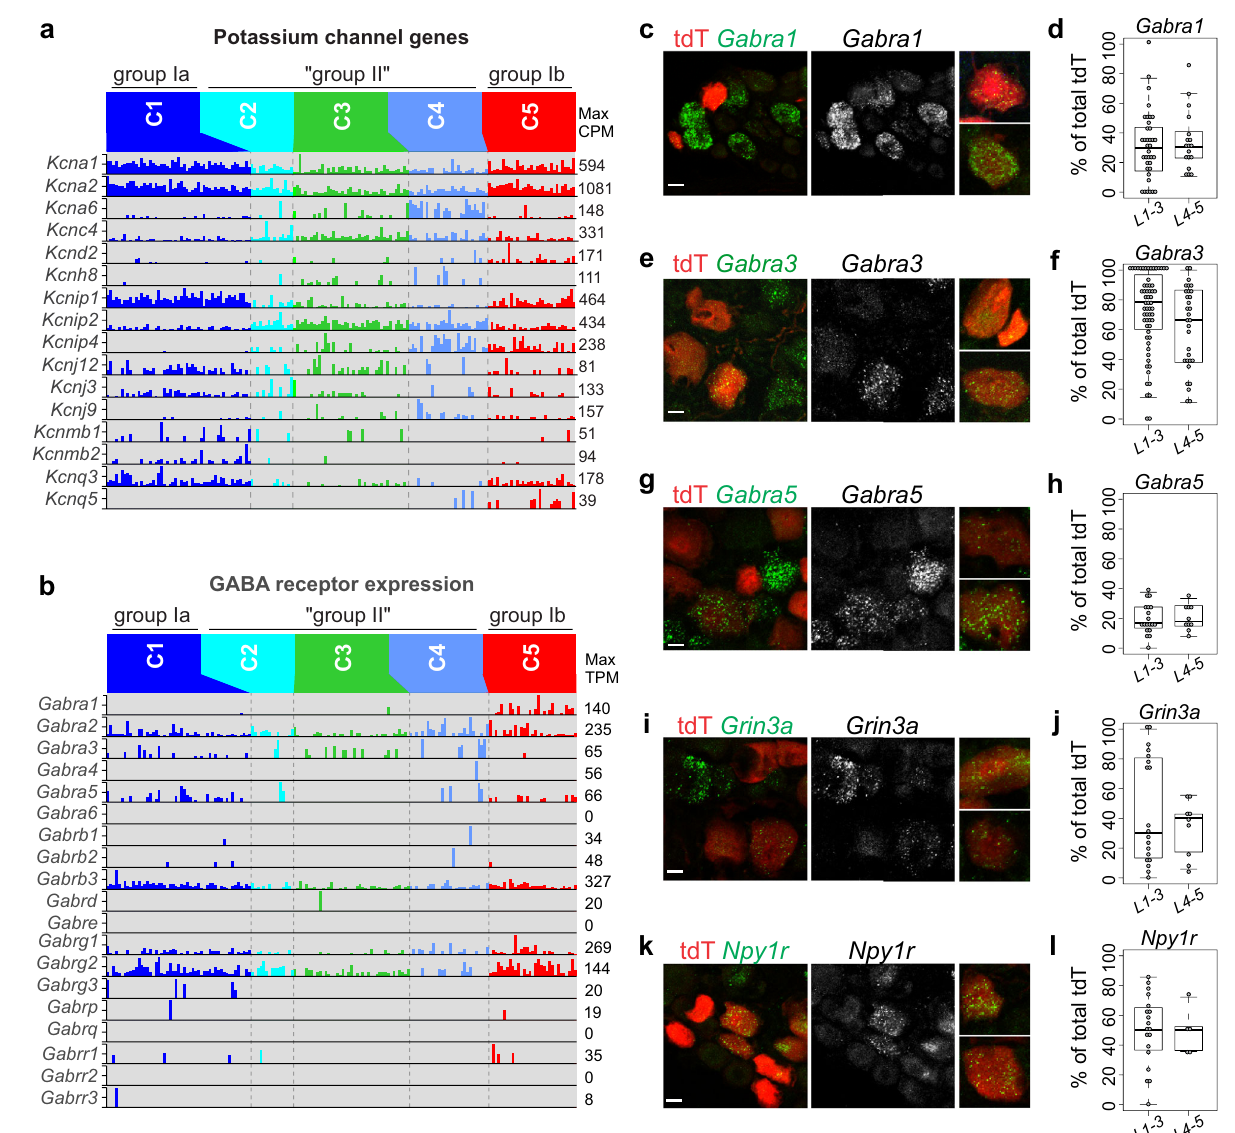
Fig. 5 Circuit features of MS and GTO afferent sensory subtypes. Bar graphs showing expression (in CPM) of annotated K v channel and auxiliary subunit genes ( a ), and GABA A receptor subunits ( b ) across the fi ve putative cell types identi fi ed from the clustering of single-cell RNAseq data. c – h Distribution patterns of the GABA A receptor units Gabra1 ( c ), Gabra3 ( e ), and Gabra5 ( g ) in tdT + neurons in adult ( ≥ p56) PVRx3:tdT mice. Images of individual neurons represent examples of observed Gabra + tdT + neurons other than those observed in the main image. Percentage of Gabra1 + tdT + ( d ), Gabra3 + tdT + ( f ), and Gabra5 + tdT + ( h ) (of all tdT + neurons) in p56 mice, at rostral (L1-3) and caudal (L4-5) lumbar levels. Mean percentage± S.E.M. Gabra1 (L1-3): 30.6 ± 3.8%, n = 37 sections, Gabra1 (L4-5): 34.2 ± 4.8%, n = 18 sections; Gabra3 (L1-3): 73.1 ± 3.7%, n = 63 sections, Gabra3 (L4-5): 61.4 ± 4.9%, n = 31 sections; Gabra5 (L1-3): 19.3 ± 2.4%, n = 19 sections, Gabra5 (L4-5): 20.5 ± 2.7%, n = 10 sections. i Grin3a receptor expression in lumbar DRG of ≥ p56 PVRx3:tdT mice. Grin3a transcript is detected in a subset of tdT + neurons. Images of individual neurons represent examples of observed Grin3a + tdT + neurons other than those observed in the main image. j Percentage of Grin3a + tdT + neurons (of all tdT + neurons) in lumbar DRG of ≥ p56 PVRX3:tdT mice. Mean percentage ± S.E.M. Grin3a (L1-3): 45.9 ± 8.4%, n = 19 sections, Grin3a (L4-5): 33.3 ± 6.4%, n = 9 sections. k Expression of Npy1r transcript in tdT + neurons in lumbar DRG of ≥ p56 PVRx3:tdT mice. Images of individual neurons represent examples of observed Npy1r + tdT + neurons other than those observed in the main image. l Percentage of Npy1r + tdT + neurons (of all tdT + ) in lumbar ganglia. Mean percentage ± S.E.M. Npy1r (L1-3): 49.9± 5.4%, n = 19 sections, Npy1r (L4- 5): 49.3 ± 6.7%, n = 5 sections. Similar data obtained from at least three ( c , e , g , i , k ) biological replicates. In boxplots ( d , f , h , j , l ), boxes indicate